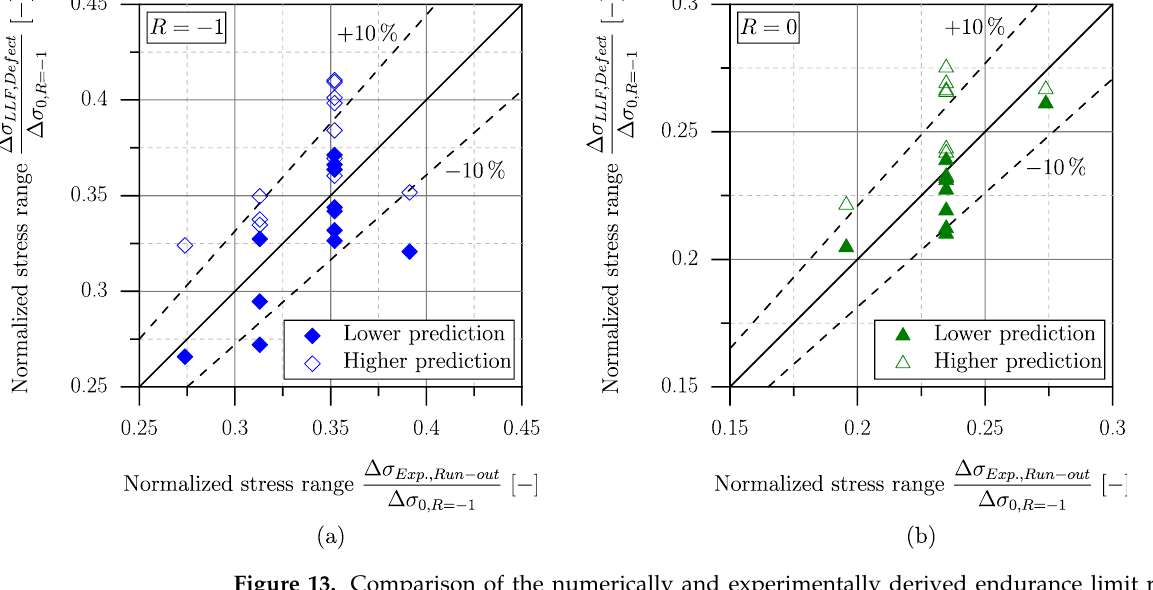
Figure 13. Comparison of the numerically and experimentally derived endurance limit results: ( a ) R = − 1; and ( b ) R = 0.